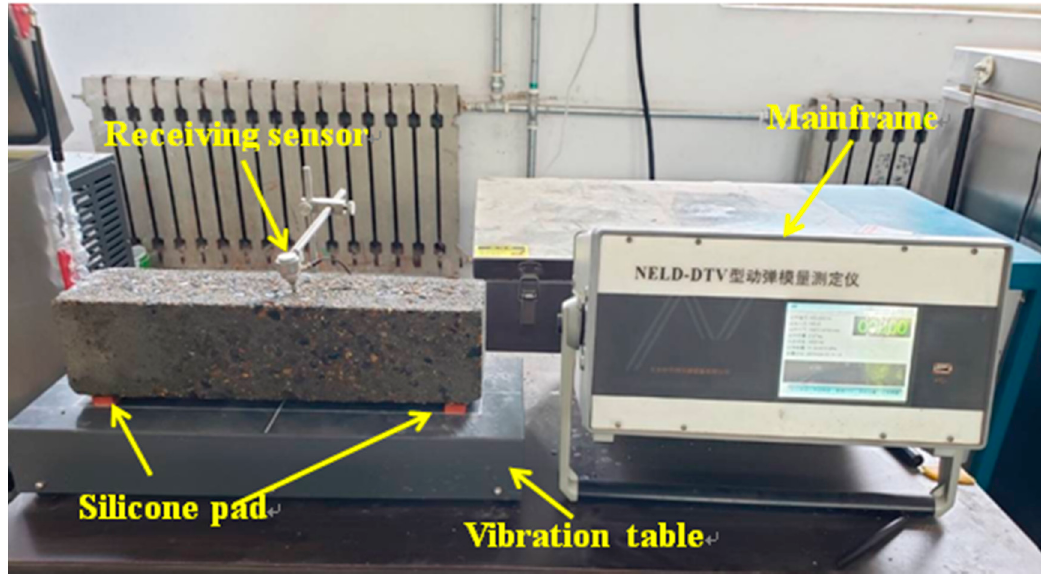
Figure 1. Dynamic elastic modulus tester.